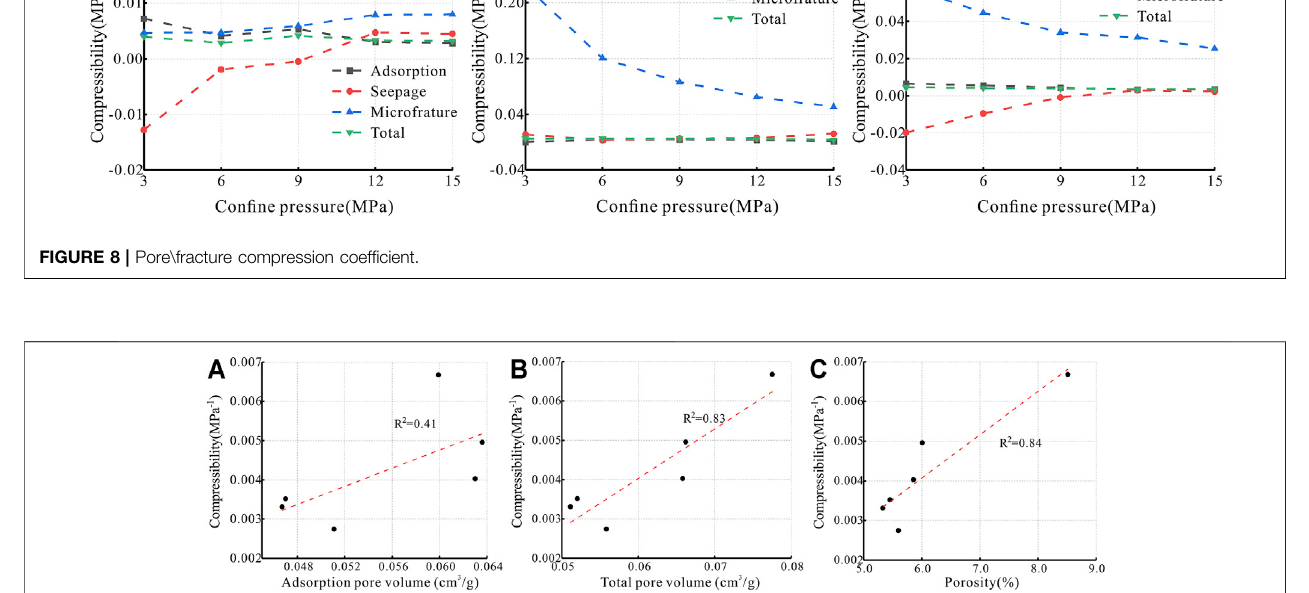
Frontiers in Earth Science |